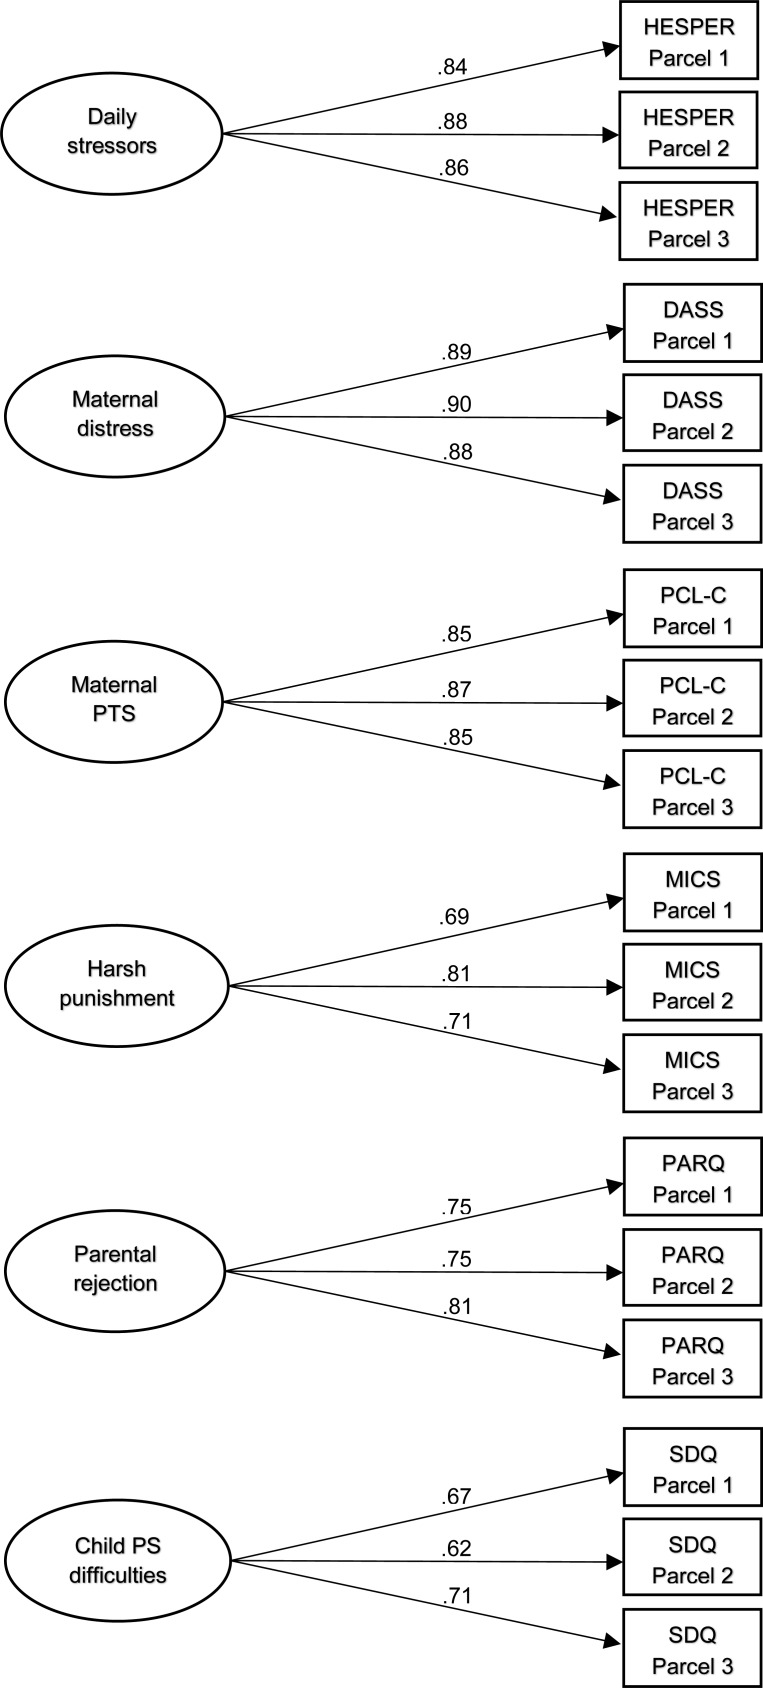
Baseline measurement model with standardized factor loadings. All factor loadings significant at p < 0.001. Model fit statistics: χ2 [120] = 183.87, p < 0.001; CFI = 0.98; RMSEA = 0.04 (90% CI 0.03–0.06); SRMR = 0.04.